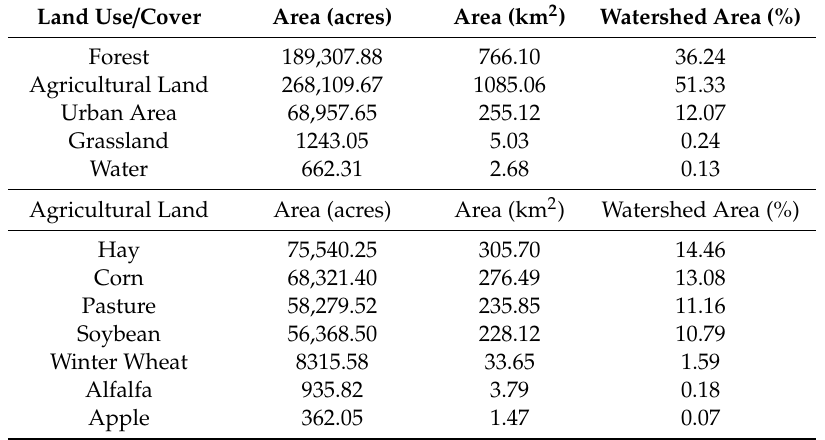
Table 1. Land use and land cover in the Monocacy River Watershed based on 2018 Crop Data Layer. Land Use /